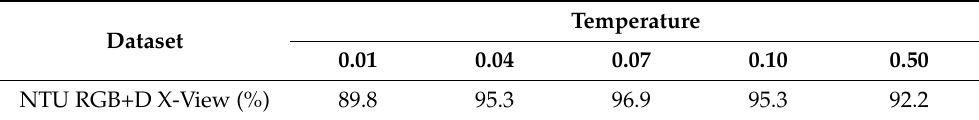
Table 6. Top 1 accuracy from various temperatures.